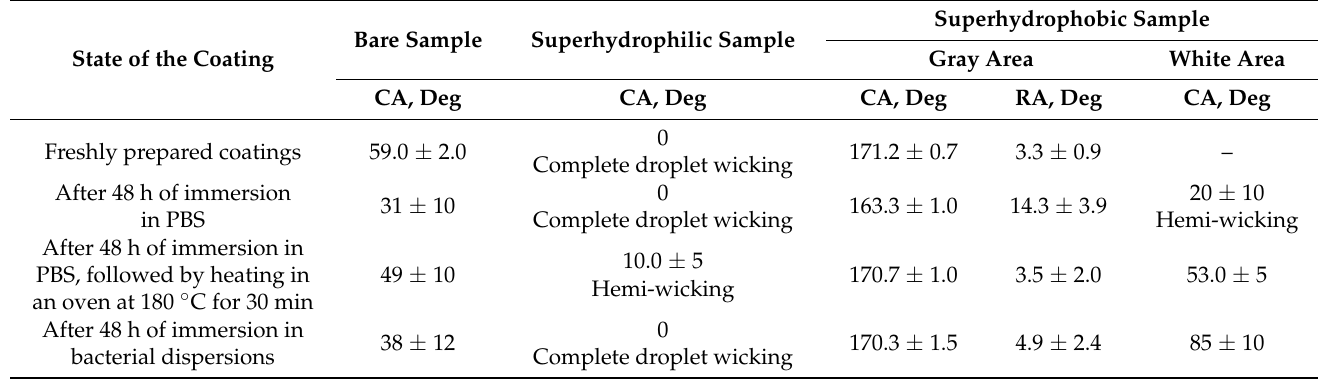
Table 1. Typical contact (CA) and roll-off (RA) angles for different samples. Bare